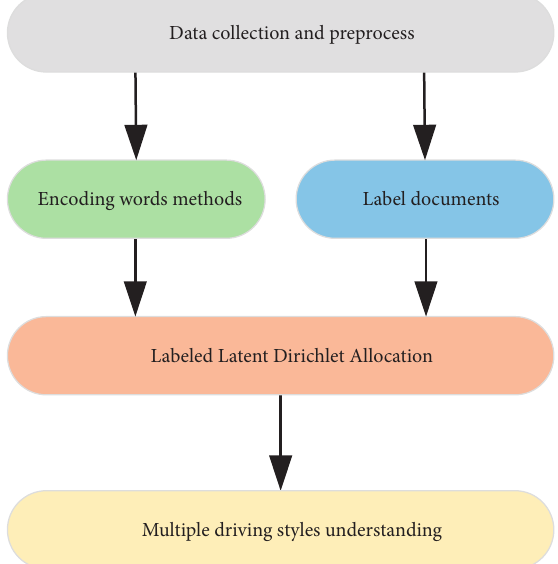
Figure 2: The structure diagram of this